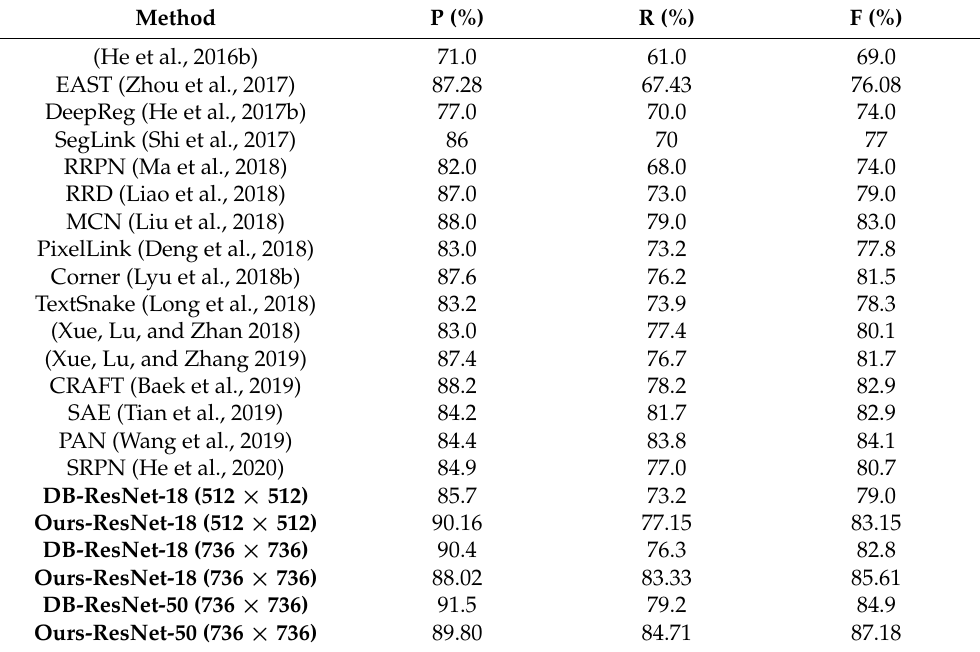
Table 8. Test results of the algorithm on MSRA-TD500 dataset (the value in brackets is the height of the input